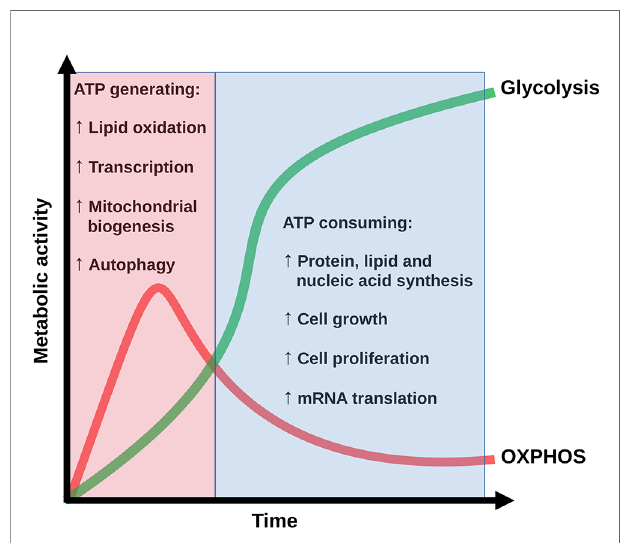
FIGURE 1 | Conceptualization of the time evolution of the OXPHOS- glycolysis shift along the bioenergetic and biosynthetic pro fi le of T CD4 cells under antigenic stimulation. Adapted from